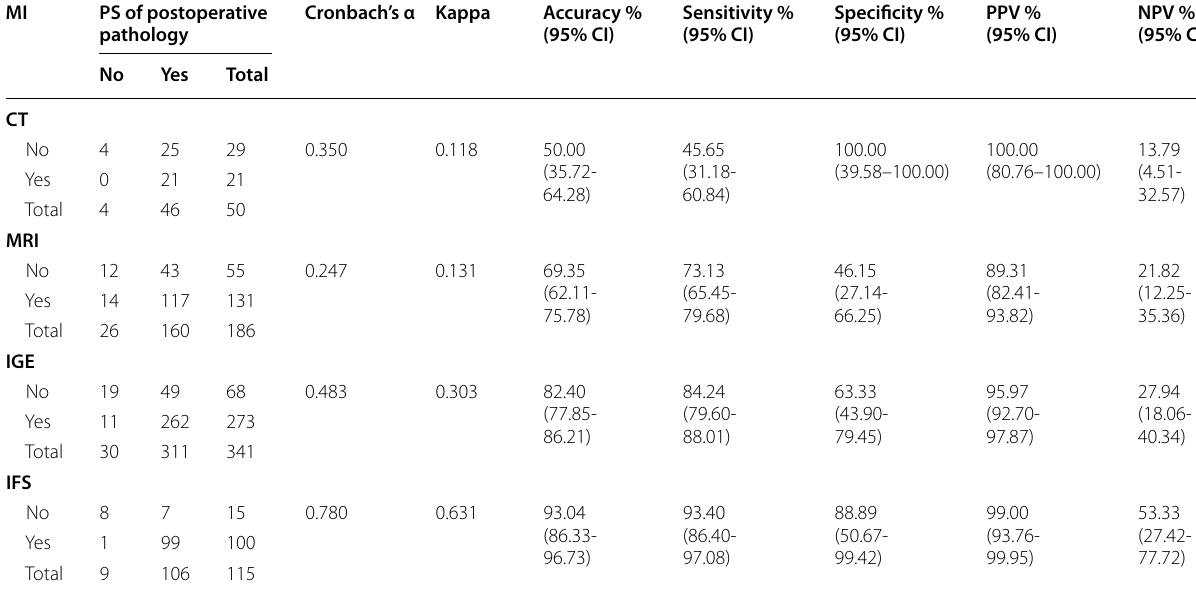
Table 3 Cronbach’s α—inter rate correlation, Kappa value, accuracy, sensitivity, specificity, PPV, NPV of the methods used for assessing myometrial invasion compared with the final paraffin-embedded pathology evaluation